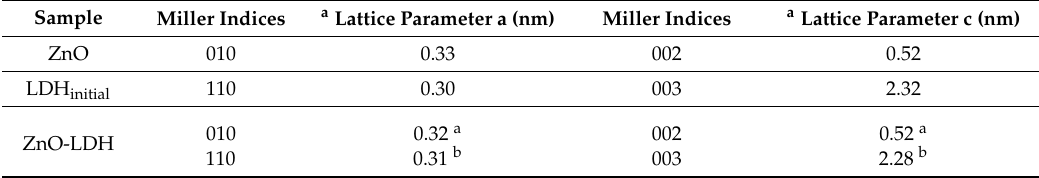
Figure 2. X-ray diffractograms for ZnO@LDH, ZnO and Mg 2 Al-CO 3 produced in reactor 1 (LDH initial ) and a mix of LDH initial and ZnO (LDH mix ). Table 2. Lattice parameters of pure and composite materials.